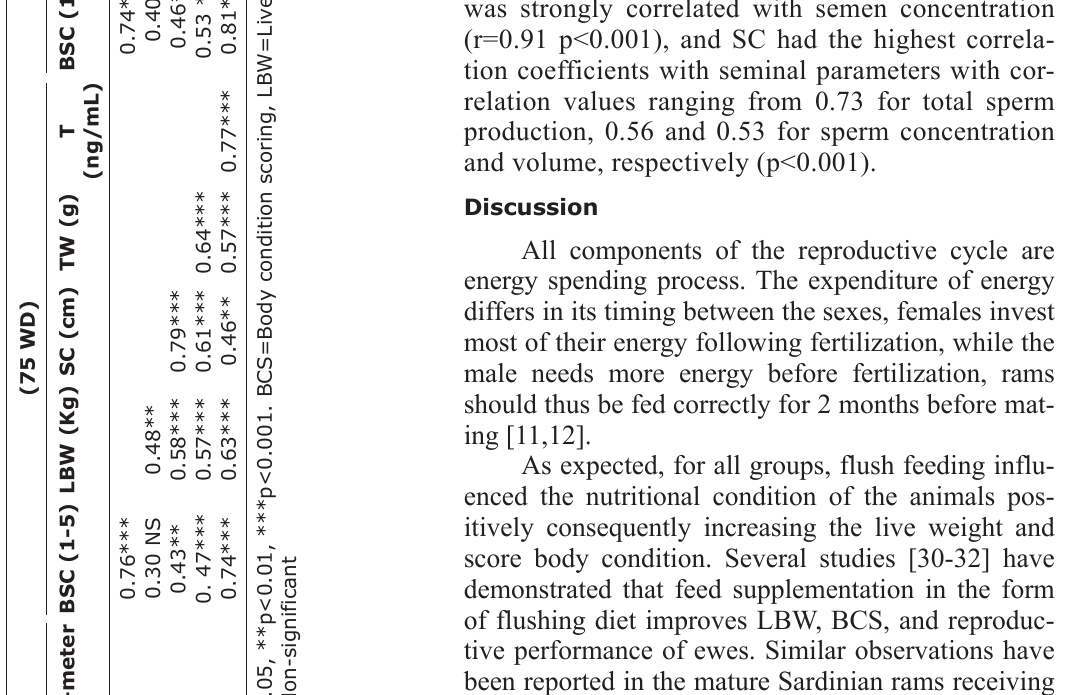
(Table-4), for 50 WD appeared to be lower (p<0.05)